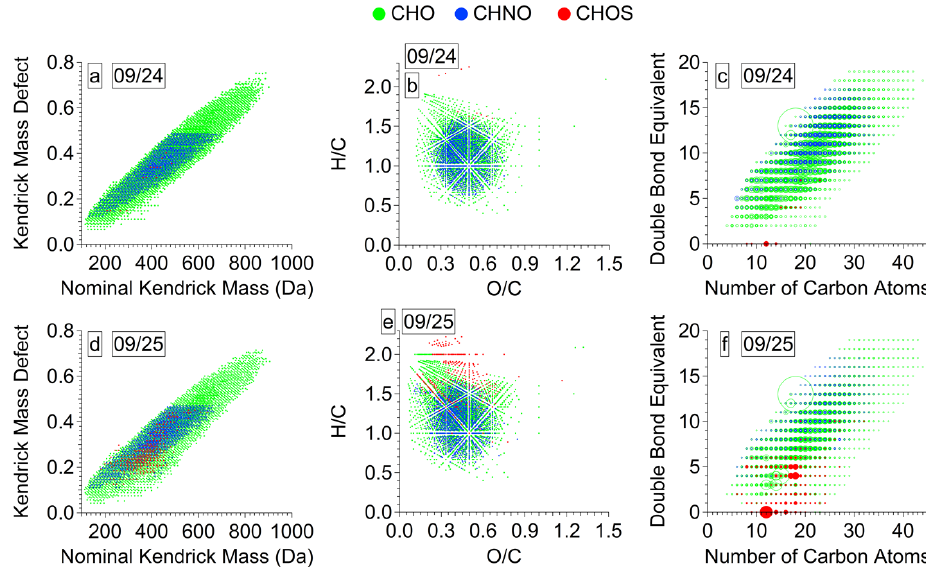
Figure 6. Characterization of all monoisotopic molecular assignments detected in WSOM of 9 / 24 (top panels) and 9 / 25 (bottom panels). Kendrick mass defect vs. nominal Kendrick mass for 9 / 24 (a) and 9 / 25 (d) . van Krevelen diagrams for 9 / 24 (b) and 9 / 25 (e) . Double bond equivalents vs. number of carbon atoms for 9 / 24 (c) and 9 / 25 (f) . The size of markers in (c) and (f) denotes relative abundance. Examples of details in all three types of graphical representations are given in the Supplement (Fig. S9). Table 3. Chemical characterization of the molecular assignments detected in selected studies. All values are average (arithmetic mean).